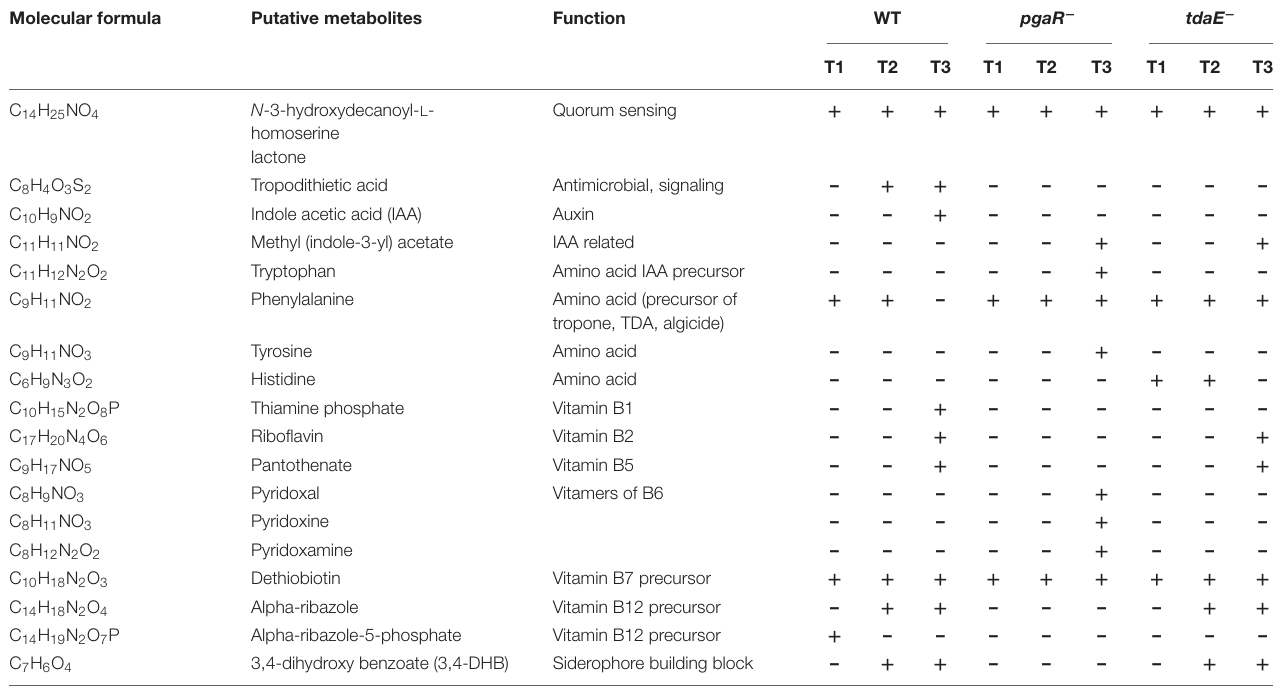
TABLE 1 | Putatively annotated ecologically relevant metabolites detected differentially in the exometabolomes of P. inhibens DSM 17395 WT and the mutants pgaR − and tdaE − .